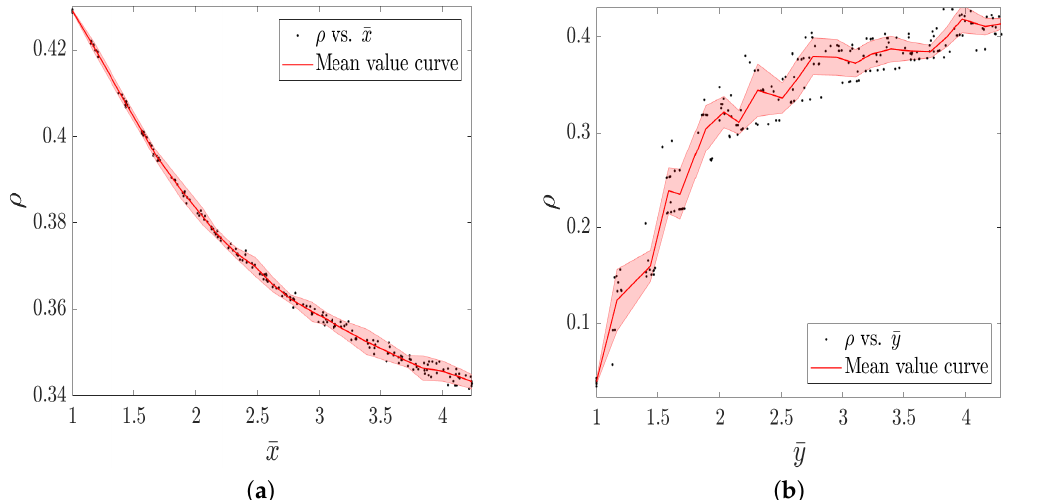
Figure 4. The infection density ρ as a function of the mean group size of information layer ¯ x ( a ) and physical layer ¯ y ( b ), respectively. The rest of other parameter values are fixed as: γ = 0.1, β = τ = δ = λ 2 = 0.5, ι = 1.1, λ 1 = η = µ = 0.9. When studying the effect of ¯ x ( ¯ y ) on the spreading prevalence, we set ¯ y = 3 ( ¯ x =